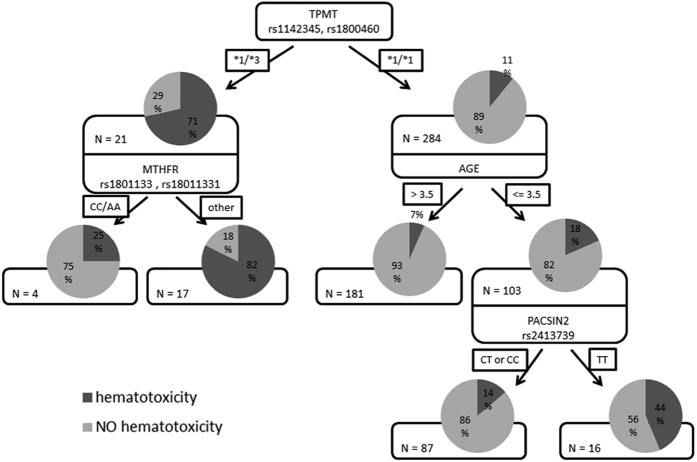
Results of CART analysis for risk of hematotoxicity.Each branch of the tree is divided by genotype and other co-variables based on the information gain criterion. The following information is presented in each node: distribution pie chart with target class probability where “hematotoxicity” class is represented in dark gray and “NO hematotoxicity” in light gray, and number of patients in each node.